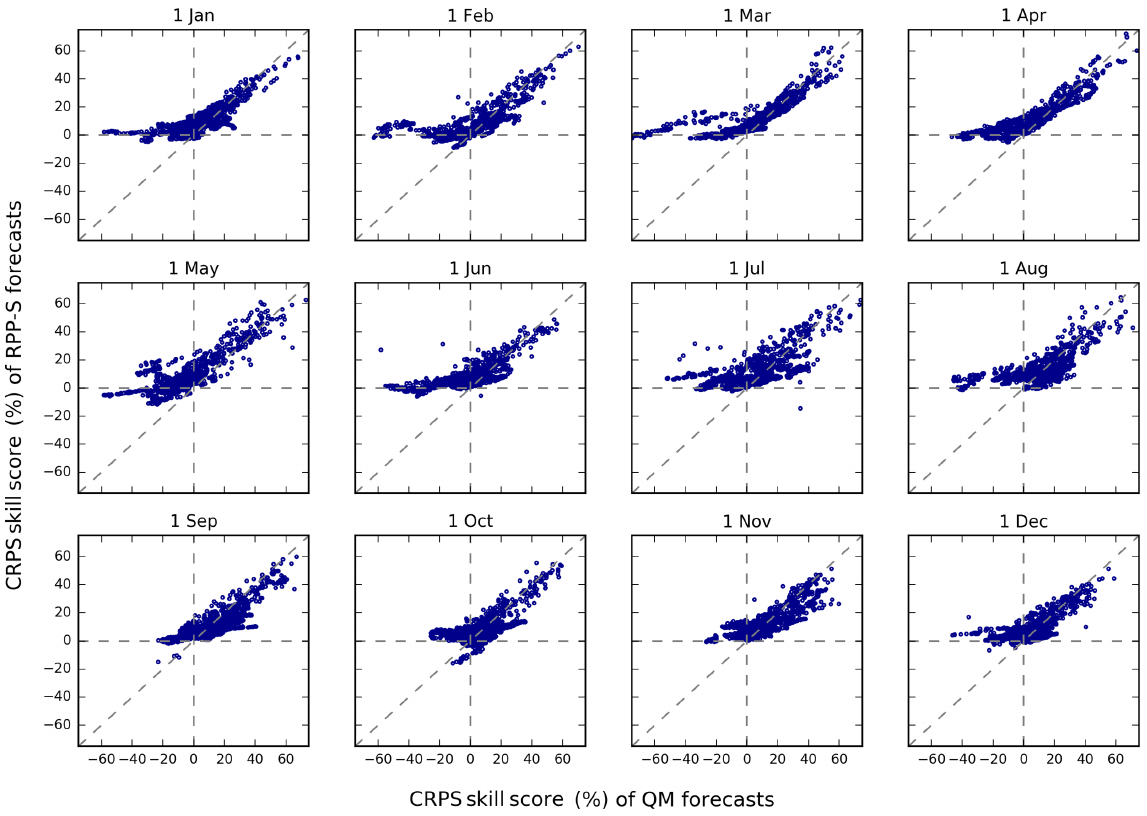
Figure 9. Scatterplots of CRPS skill scores for accumulated totals for each initialisation date. The scatterplots plot QM skill scores (horizontal axis) against RPP-S skill scores (vertical axis). Each scatterplot combines results for all catchments and all lead